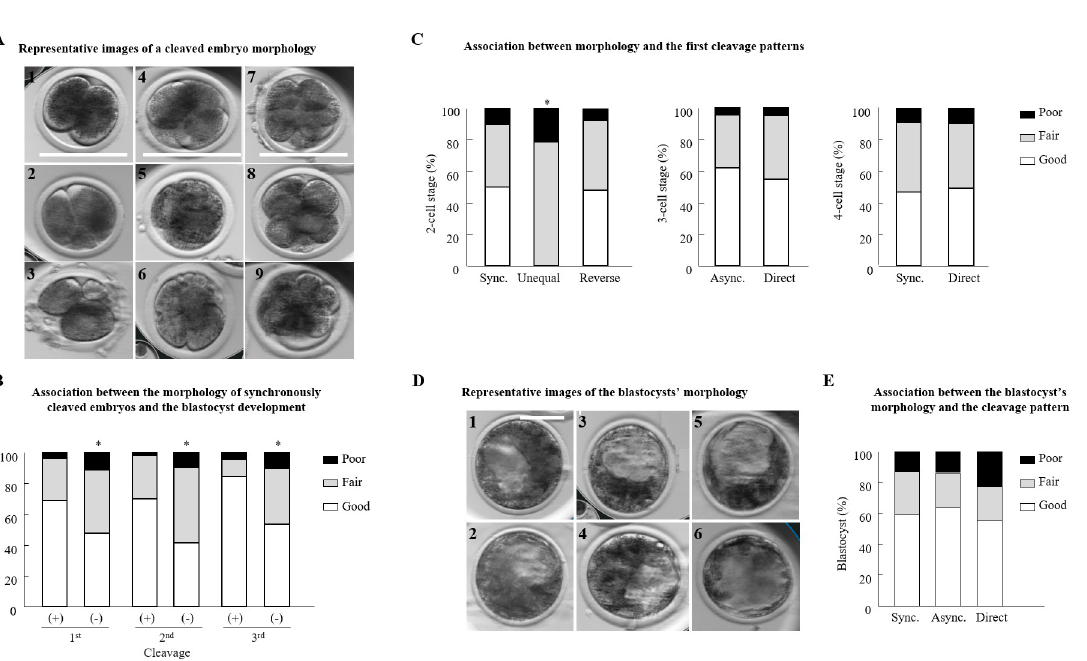
Fig 3. Morphology of bovine cleaved embryos. (A) Representative images of a 2-cell stage embryo with equal-sized blastomeres (1, good morphology); a 2-cell stage embryo with equal sized blastomeres and up to 20% fragmentation (2, fair morphology); a 2-cell stage embryo with unequal sized blastomeres and > 50% fragmentation (3, poor morphology); a 4-cell stage embryo with four equal sized blastomeres (4, good morphology); a 4-cell stage embryo with fragmentation, equal sized blastomeres (5, fair morphology); a 4-cell stage embryo with unequal sized blastomeres and > 50% fragmentation (6, poor morphology); an 8-cell stage embryo with equal sized blastomeres (7, good morphology); an 8-cell stage embryo with unequal sized blastomeres and minor ( < 20%) fragmentation (8, fair morphology); and an 8-cell stage embryo with unequal sized blastomeres and severe ( > 50%) fragmentation (9, poor morphology). (B) Distribution of normal synchronously cleaved embryos that developed (+) or did not (-) to the blastocyst stage into the different morphological categories (good, fair, and poor). A Chi-squared test, followed by Fisher’s exact test, was used for pair comparison within each cleavage. � P < 0.05; n = 431 embryos. (C) Distribution of 2-cell stage embryos with different cleavage patterns (synchronous; sync, unequal, and reverse) in different morphological categories. A Chi-squared test was followed by Pearson’s test; � P < 0.05; n = 403 embryos. Distribution of 3-cell stage embryos (from asynchronous and direct cleavage) in different morphological categories; n = 188 embryos. Distribution of 4-cell stage embryos (from synchronous and direct cleavage) in different morphological categories; n = 319 embryos. The distribution in morphological categories was calculated from cleaved embryos. A Chi-squared test, followed by Fisher’s exact test, was used. (D) Representative images of blastocysts with evident inner cell mass (ICM) with many tightly packed cells and many trophoblast (TE) cells forming a cohesive epithelium (1 and 2, good morphology); a blastocyst with a few TE cells forming a loose epithelium (3 and 4, fair morphology); a blastocyst with ICM presenting loosely grouped cells and TE composed of very few cells (5, fair morphology); a blastocyst with ICM presenting loosely grouped cells and TE composed of a few large cells (6, fair morphology), bar = 100 μ m. (E) The distribution of synchronously (Sync), asynchronously (Async), and directly (Direct) cleaved embryos that developed to the blastocyst stage in the different morphological categories. A Chi-squared test, followed by Pearson’s test, was used, n = 170 blastocysts.